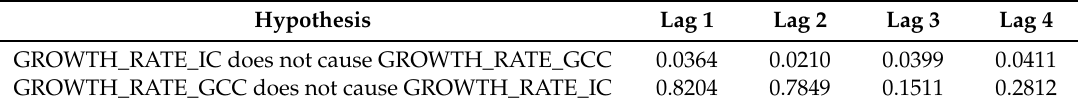
Table 4. Granger causality test for the growth rates of installed capacity and grid-connected capacity. Hypothesis